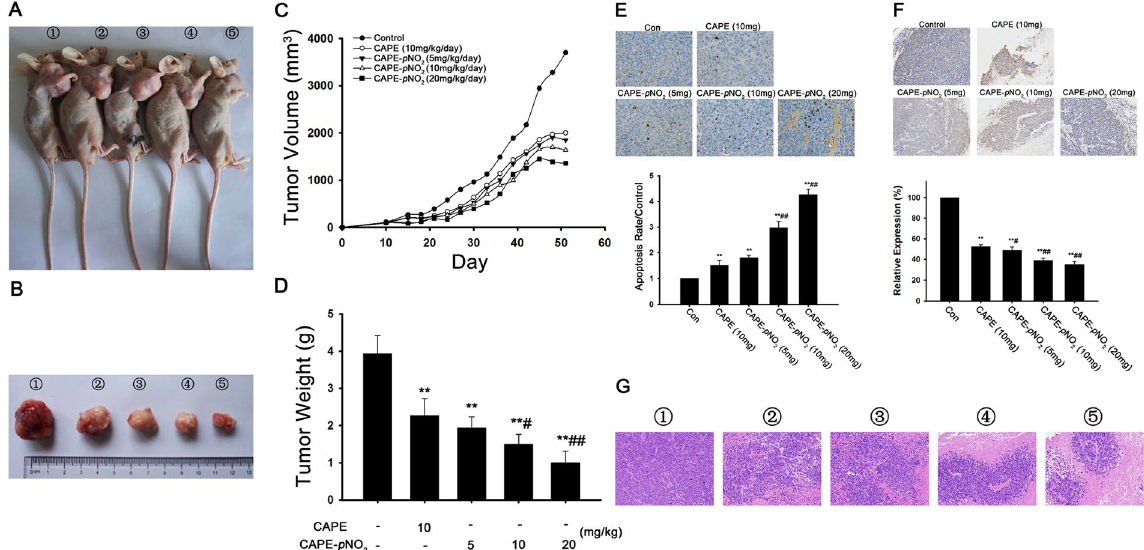
Figure 6. CAPE and CAPE- p NO 2 inhibit tumour growth in vivo . After 41-day treatment, tumours were observed in vivo (A) and in vitro (B) ; ① , ② , ③ , ④ and ⑤ represented the control, CAPE-10 mg/kg/day, CAPE- p NO 2 -5 mg/kg/day, CAPE- p NO 2 -10 mg/kg/day and CAPE- p NO 2 -20 mg/kg/day groups, respectively. (C) After nude mice were injected with HT-29 cells for 9 days, CAPE and CAPE- p NO 2 were given intragastrically for 42 days. The tumour volume was measured every three days. (D) Inhibition rate of tumour growth after treatment with CAPE and CAPE- p NO 2 . Apoptosis and expression were detected by TUNEL and immunohistochemistry. (E) TUNEL staining in tumours cells ( × 400), and the relative apoptosis rate was calculated using Image-Pro Plus (IPP) software. (F) Results of immunohistochemistry ( × 200). The integrated option density (IOD) value was used to measure the expression level of VEGF. (G) The paraffin sections of tumours were stained with haematoxylin and eosin (HE), and the necrotic area and shrinking nucleus were increased after treatment in a dose-dependent manner; ① , ② , ③ , ④ and ⑤ represented the control, CAPE-10 mg/kg/day, CAPE- p NO 2 -5 mg/ kg/day, CAPE- p NO 2 -10 mg/kg/day and CAPE- p NO 2 -20 mg/kg/day groups. Values represented the means ± SD from three independent experiments, and error bars represented the STDEV (SD). * p < 0.05, ** p < 0.01: CAPE and CAPE- p NO 2 compared with the control. # p < 0.05, ## p < 0.01: CAPE- p NO 2 (5, 10, 20 mg/kg/day) compared with CAPE (10